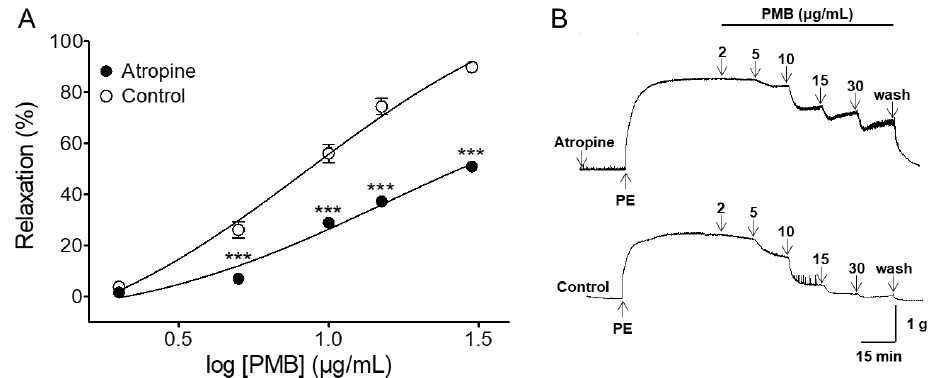
Figure 4. Relaxation responses induced by PMB (2–30 μg/mL) on phenylephrine (PE, 1 μM)-pre- contracted aortic rings in the presence or absence (control) of atropine (1 μM) ( A ). Representative traces under the indicated conditions ( B ). Values are expressed as mean ± SEM ( n = 6). *** p < 0.001 vs. control.